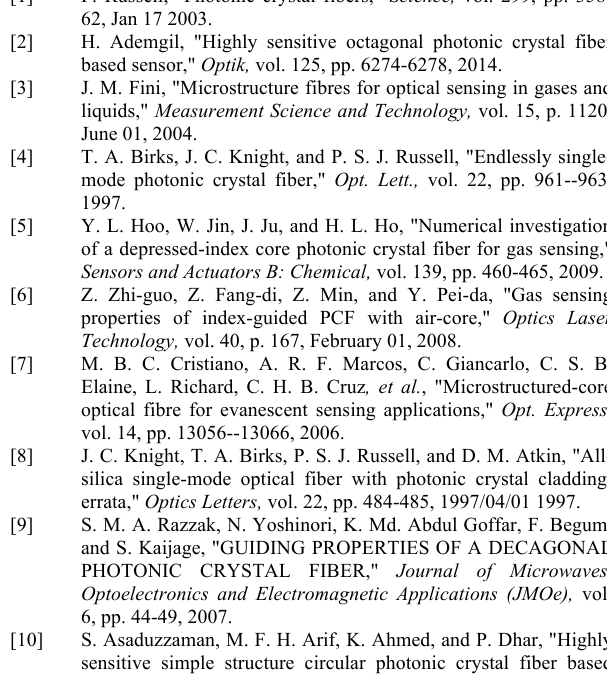
FIGURE 7. Impact of the number of layers on a) the relative sensitivity and b) the confinement loss in the cladding region.